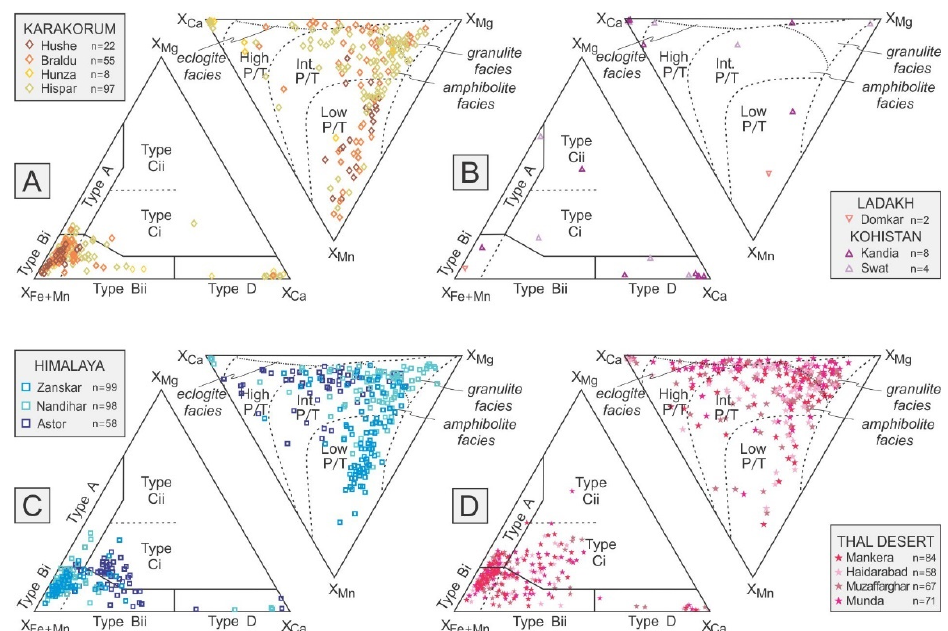
Figure 4. Chemical composition of detrital garnet in river sands of northern Pakistan ( A = Karakorum, B = Ladakh and Kohistan arcs, C = Himalaya) and in the ( D ) Thal Desert. (Fe + Mn–Mg–Ca plot after Mange and Morton [5]; Ca–Mg–Mn plot after Win et al. [121]). XFe, XMg, XCa, XMn = molecular proportions of Fe 2+ , Mg, Ca, and Mn.